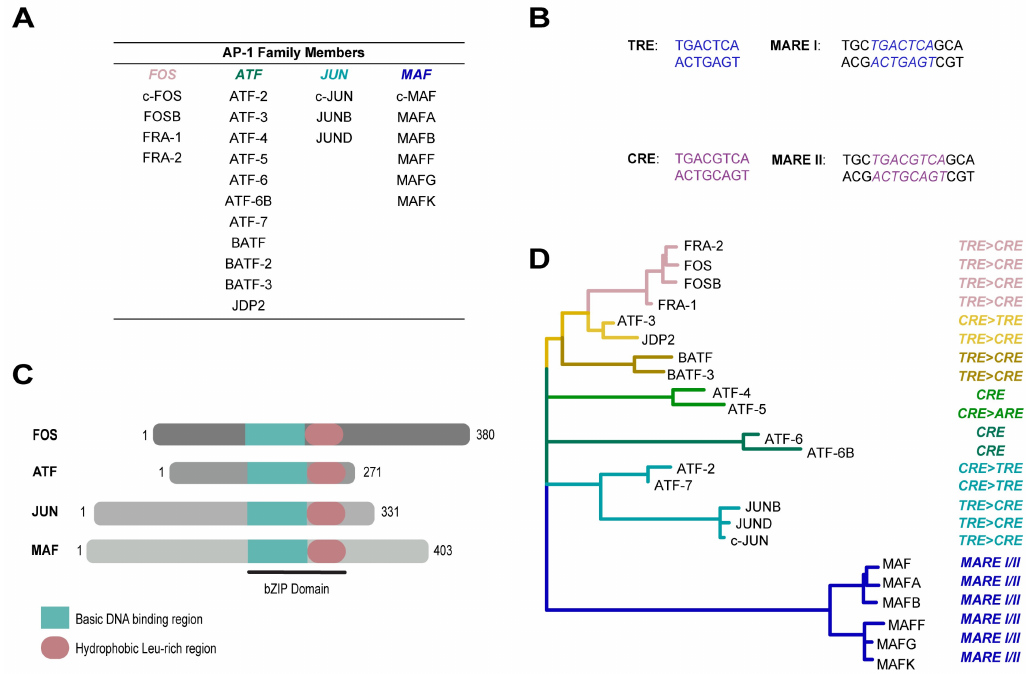
Figure 1. The AP-1 transcription factor family members. ( A ) Table of the different AP-1 transcription factor family subgroups FOS, ATF, JUN and MAF; ( B ) The different DNA response-elements (REs) that AP-1 TFs recognise and to which they bind. The 12- O -tetradecanoylphorbol-13-acetate response element (TRE) is the most common; however, depending on dimer configuration, AP-1 TFs can bind to additional elements, such as CRE, MARE I, and MARE II. Note MARE I is an extension of TRE, whereas MARE II is an extension of CRE; ( C ) Schematic representation of the structure of AP-1 proteins including FOS, ATF, JUN, and MAF. AP-1 TFs share two common regions, the basic motif and the leucine zipper; together these regions form the bZIP domain. Sequence data was exported from Nextprot; ( D ) Phylogenetic tree of AP-1 transcription factor family members and their binding REs. The amino acid sequences were aligned with ClustalW implemented with MEGA 7.0.21. The alignment was manually rearranged in Bioedit 7.0.8.0. In order to find the best-fit amino acid substitution model for the alignment, a model test was performed with MEGA 7.0.21. The Maximum Likelihood tree was also calculated with MEGA 7.0.21, applying the parameters obtained from